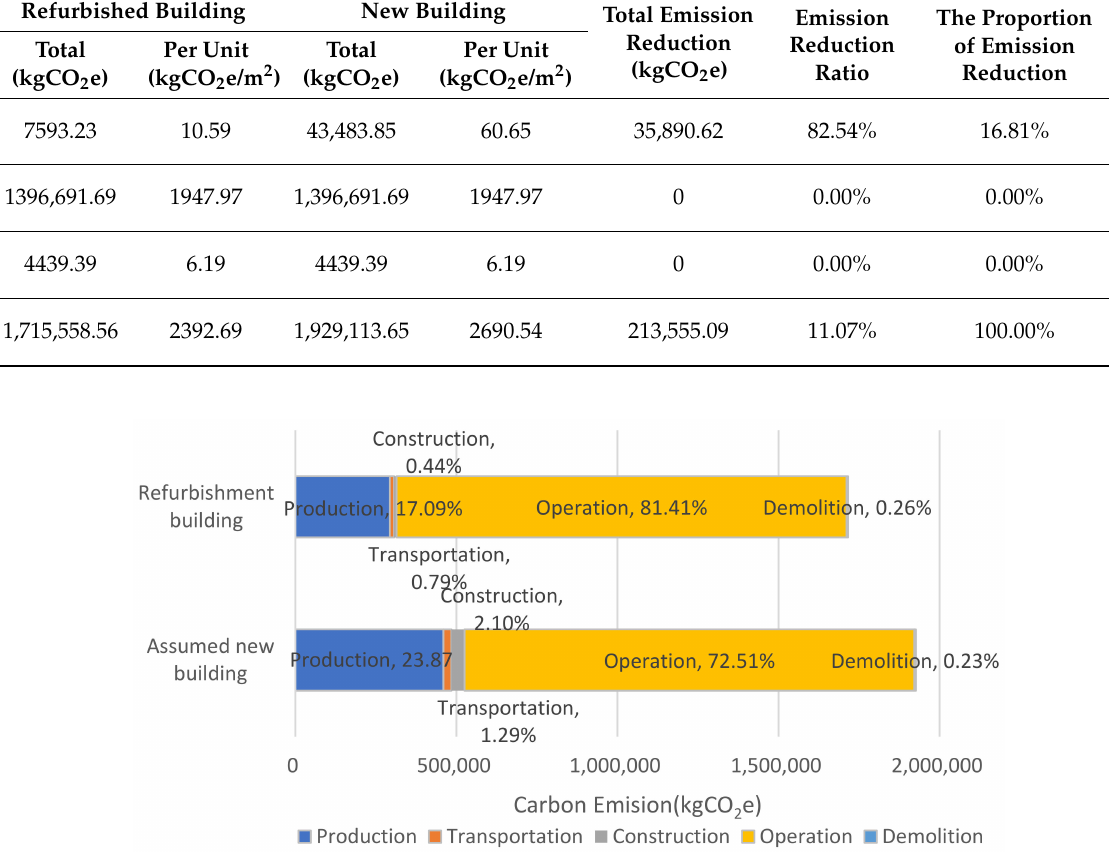
Figure 8. Carbon emission of refurbishment building and new building and proportion of each phase in the whole life